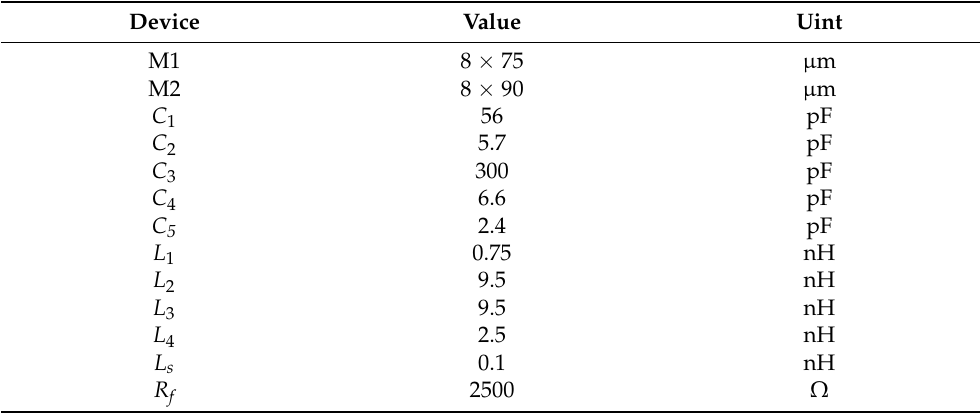
Table 1. Values of components in circuit.